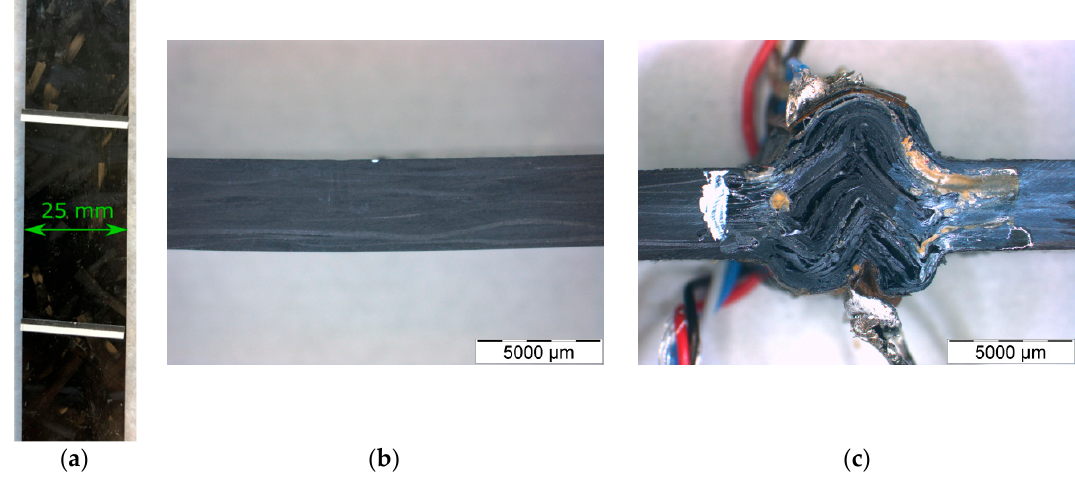
Figure 10. Tested creep specimens of Polynt SMCarbon 80 CF60-3K / 2 at 47 MPa in-plane stress. ( a ) after 84 h in a tensile test setup; ( b ) after 84 h in a bending test setup; ( c ) collapsed after 5 min in a compression test setup.